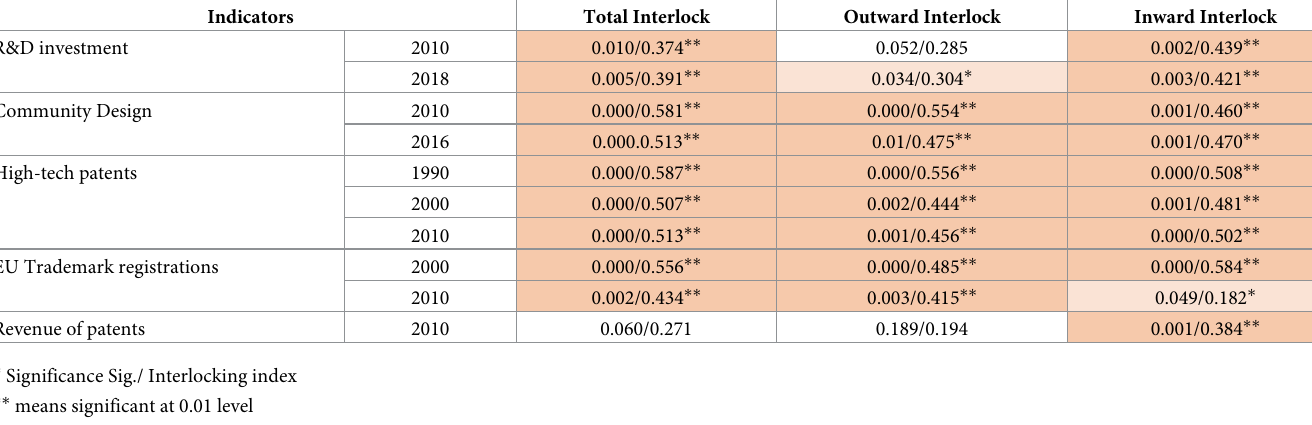
Table 5. The relationship between technology indicators and three interlock types.